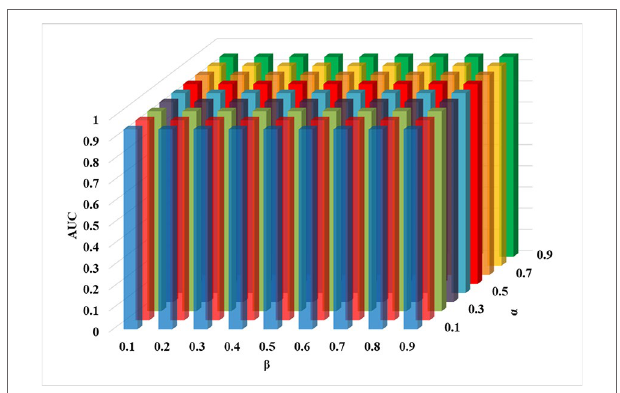
FIGURE 7 | The AUC of the parameter α and β based on the fixed parameter γ and k .